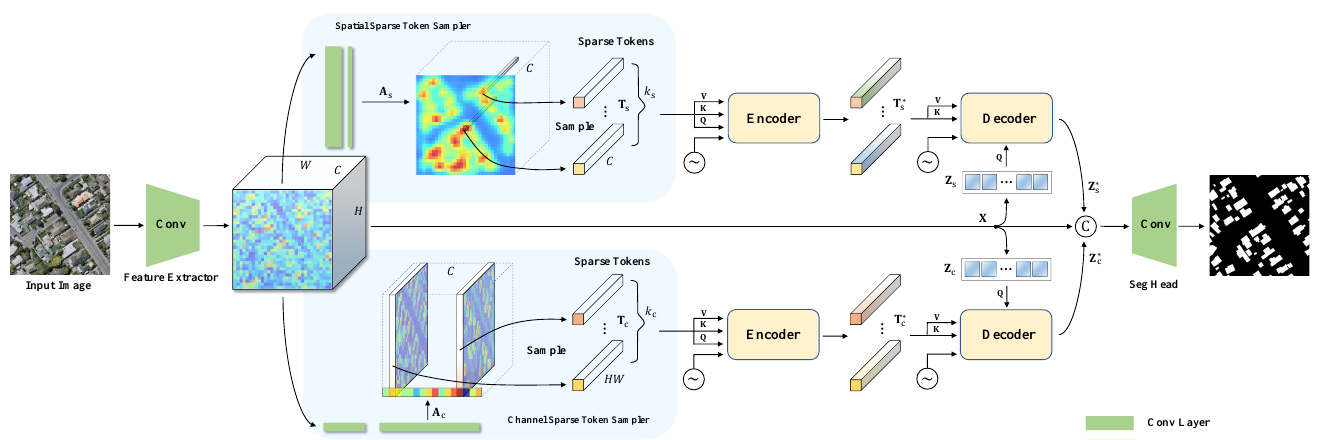
Figure 2. An overview of the proposed method. Our method consists of a CNN feature extractor, a spatial/channel sparse token sampler, a transformer-based encoder/decoder, and a prediction head. In the transformer part, when modeling the long-range dependency between different channels/spatial locations of the input image, instead of using all features vectors, we select the most important k s ( k s (cid:28) HW ) spatial tokens and k c ( k c (cid:28) C ) channel tokens. The sparse tokens greatly reduce the computational and memory consumption. Based on the semantic tokens generated by the encoder, a transformer decoder is employed to refine the original features. Finally, in our prediction head, we apply two upsampling layers to produce high-resolution building extraction results.